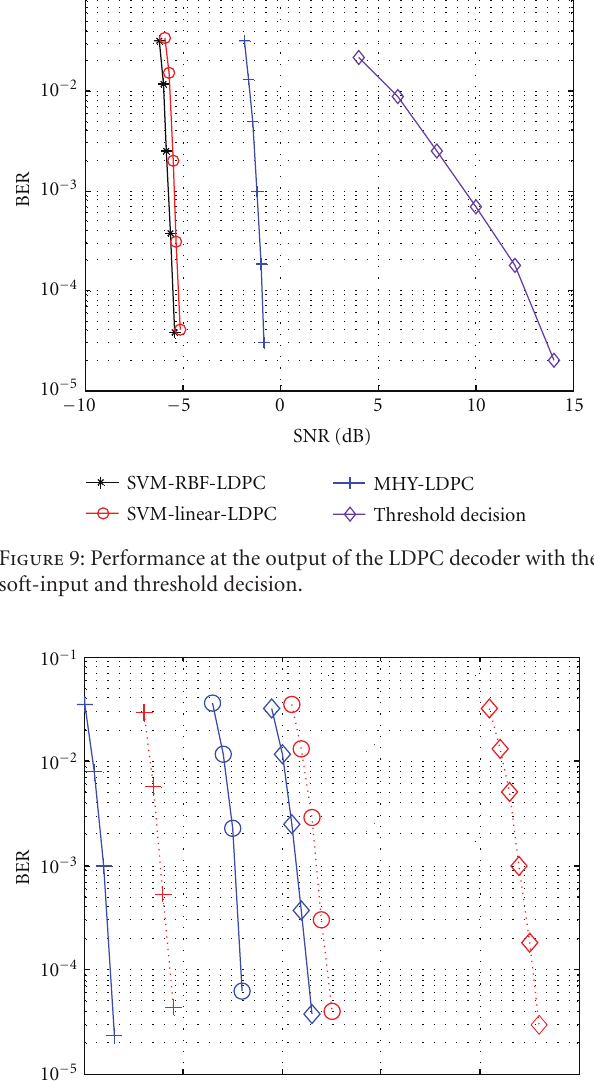
Figure 8: The posterior probability P ( y = 1 | x ) obtained by SVM and MHY method, in (a) and (b), respectively, where source symbols with all ones are transmitted.